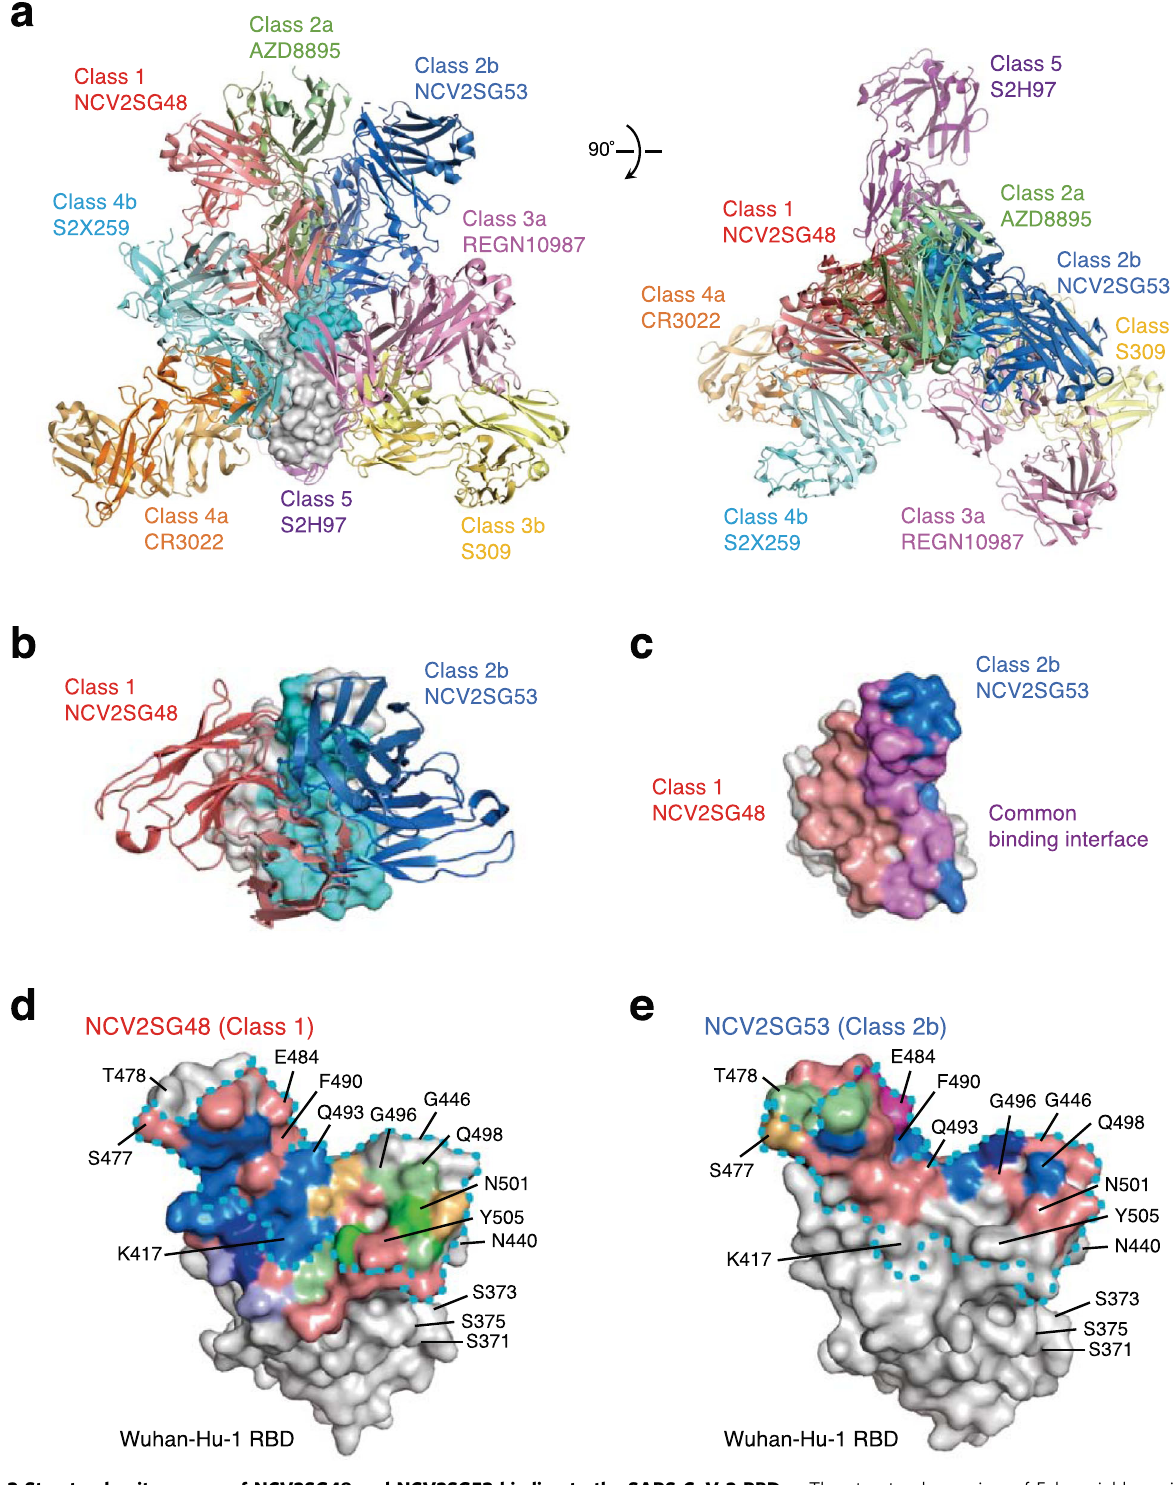
Fig. 3 Structural epitope map of NCV2SG48 and NCV2SG53 binding to the SARS-CoV-2 RBD. a The structural overview of Fab variable regions of NCV2SG48 (Class 1) and NCV2SG53 (Class 2b) together with a reported different class of neutralizing mAbs, AZD8895 (Class 2a), REGN10987 (Class 3a), S309 (Class 3b), CR3022 (Class 4a), S2X259 (Class 4b), and S2H97 (Class 5), complexed with Wuhan RBD. RBD is shown as the surface model ( gray ) with the ACE2-binding interface ( cyan ). b NCV2SG48 and NCV2SG53 complexed with Wuhan RBD. c Binding interface on Wuhan RBD with NCV2SG48 ( pink ), NCV2SG53 ( blue ), or common ( purple ). d , e The Binding interface ( pink ) of NCV2SG48 and NCV2SG53 are shown on the surface model of Wuhan RBD. The ACE2-binding site is surrounded by a dotted line ( cyan ). Residues forming a hydrogen bond with HC ( blue ), HC via water ( light purple ), HC and HC via water ( dark blue ), LC ( light green ), LC via water ( gold ), LC and LC via water ( green ), and HC, HC via water, and LC ( purple ) are